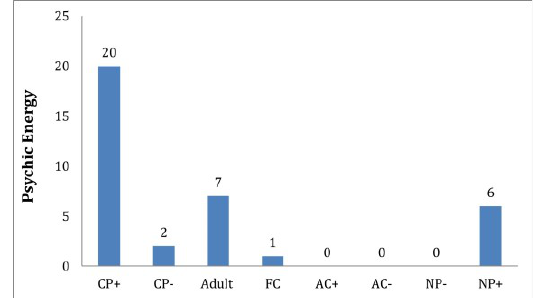
Chart 5: Egogram Teacher 3 with Student 1